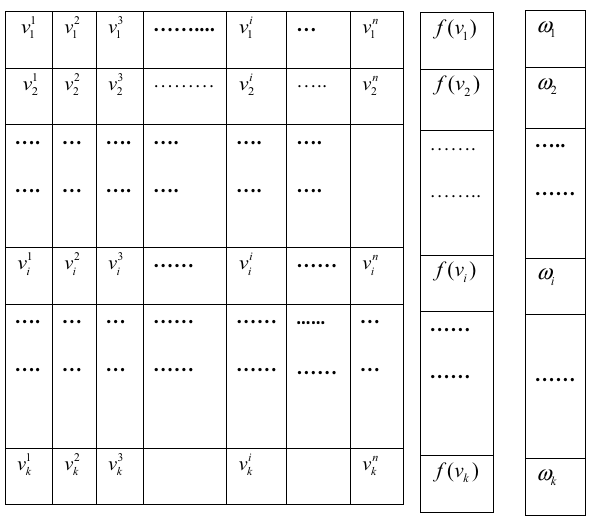
Fig. 2 Solution matrix created by ACO. The solutions are to be kept in the order of their weights ( bottom. For minimization problem, f ( v 1 ) ≤ f ( v 2 ) ≤